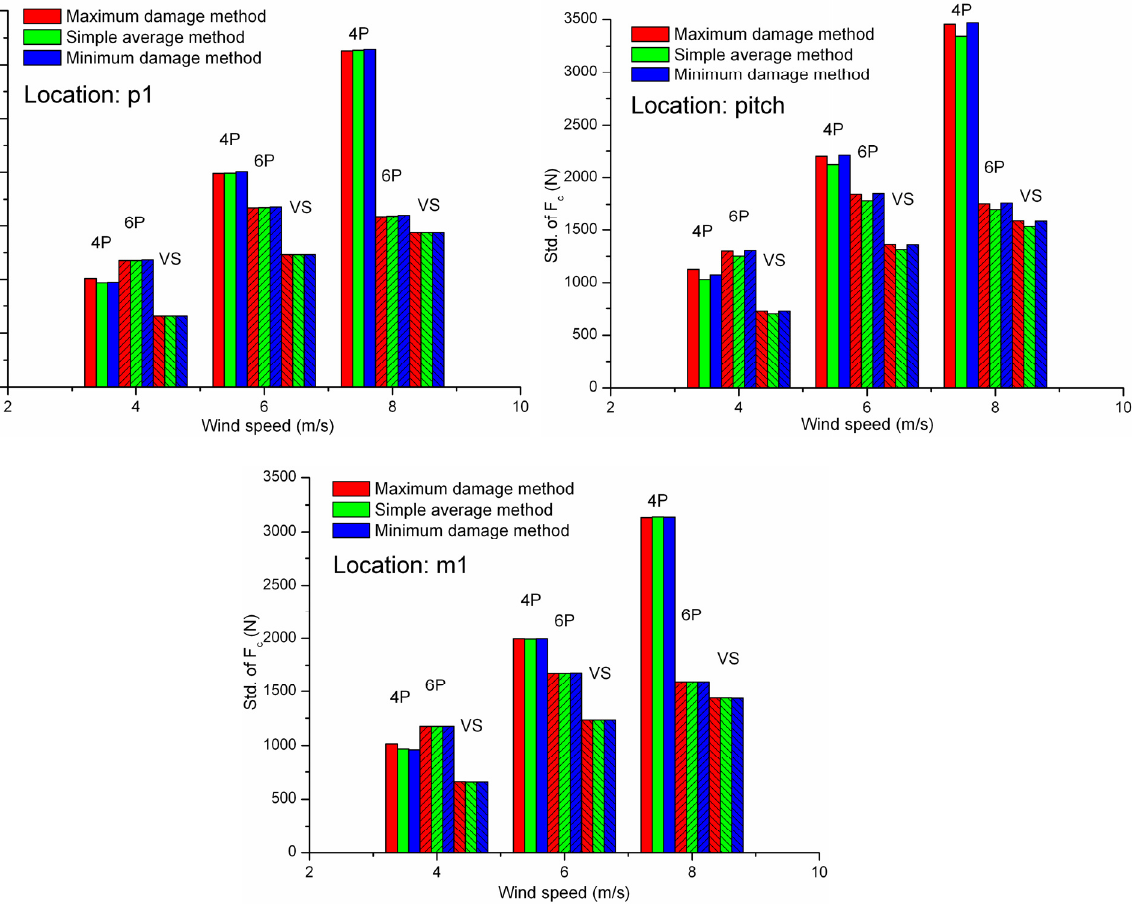
Figure 23. Comparison of standard deviations of contact forces when using different methods at different contact points, generators and wind